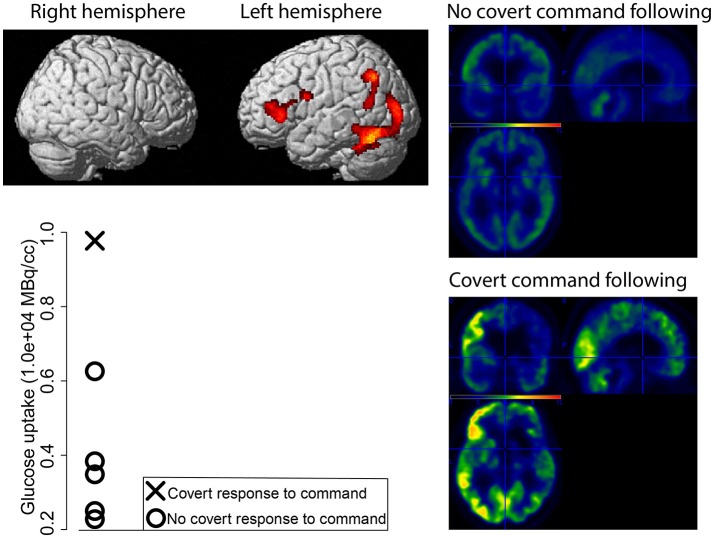
Preserved glucose metabolism (in red-yellow) as measured with FDG-PET for the MCS– patient with signs of “covert command following” compared to patients with a FDG-PET indicative of MCS without signs of “covert command following” (top left). Mean glucose uptake of the more significant cluster (in MBq/cc) for every patient (bottom left, patients with a MCS FDG-PET in absence of “covert command following” represented with circles, the MCS– patient who did show signs of “covert command following” represented with a cross). Average standardized uptake value for the patients without “covert command following” (right top), and the standardized uptake value for the patient with “covert command following” (bottom right).